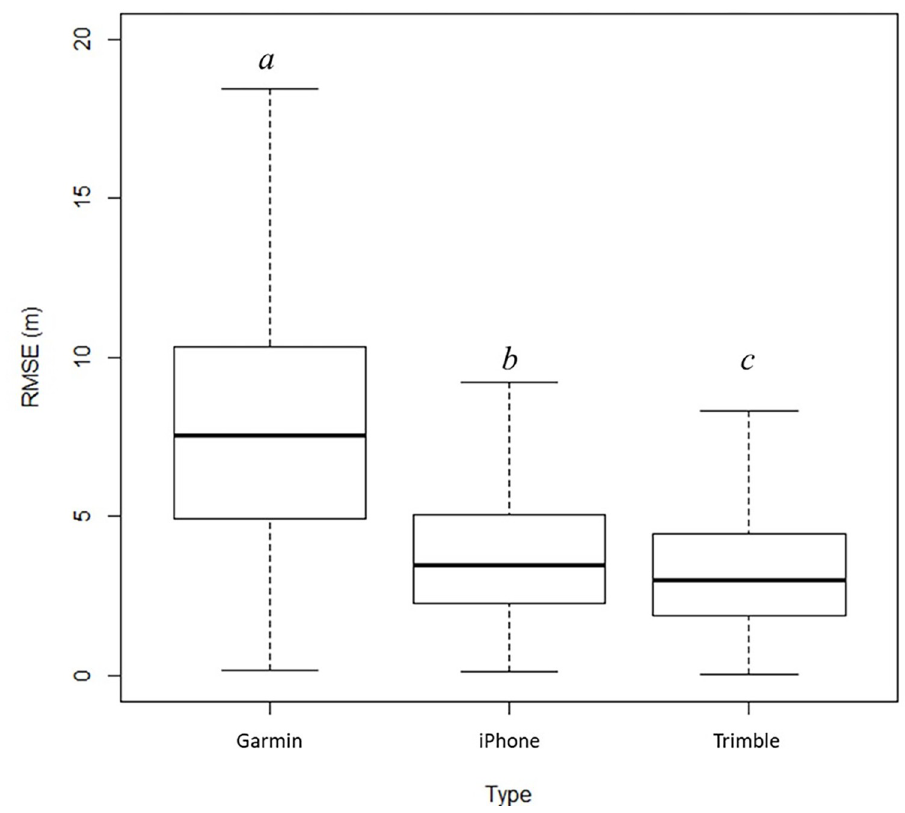
Fig 3. Boxplot for horizontal positional accuracy (RMSE, root mean square error) by GNSS receiver types. A different letter indicates statistically significant differences ( p -value <